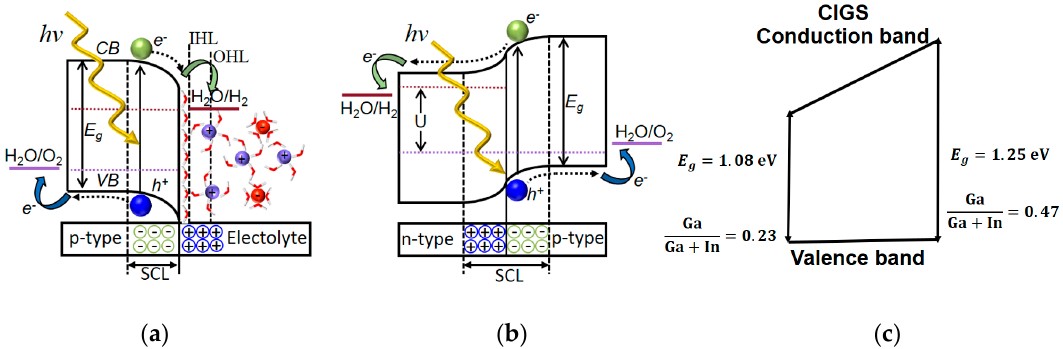
Figure 2. Schematic picture of band bending of ( a ) p-type semiconductor material in contact with an alkaline electrolyte, ( b ) band bending in a solid-state p–n-homojunction, and ( c ) valence band (VB) and conduction band (CB) edge energies of CuInGaSe 2 (CIGS) with the different Ga/Ga + In ratios used in this study (without contact material).